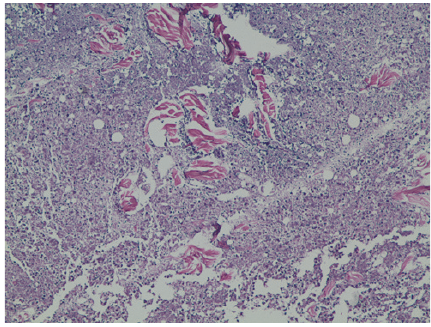
Figure 3: Histopathology from skin biopsy of the upper back showing fibroadipose tissue and skeletal muscle with focal acute and chronic